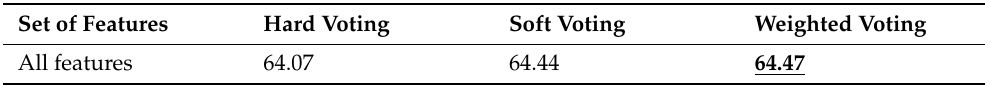
Table 6. Results obtained for the three voting approaches with different types of score calculation. Classifiers were trained using all features.